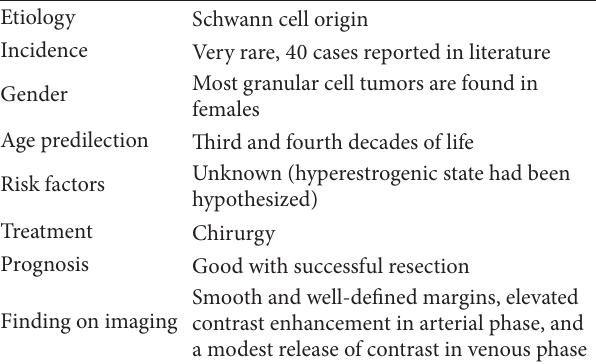
Table 1: Summary of granular cell tumor of